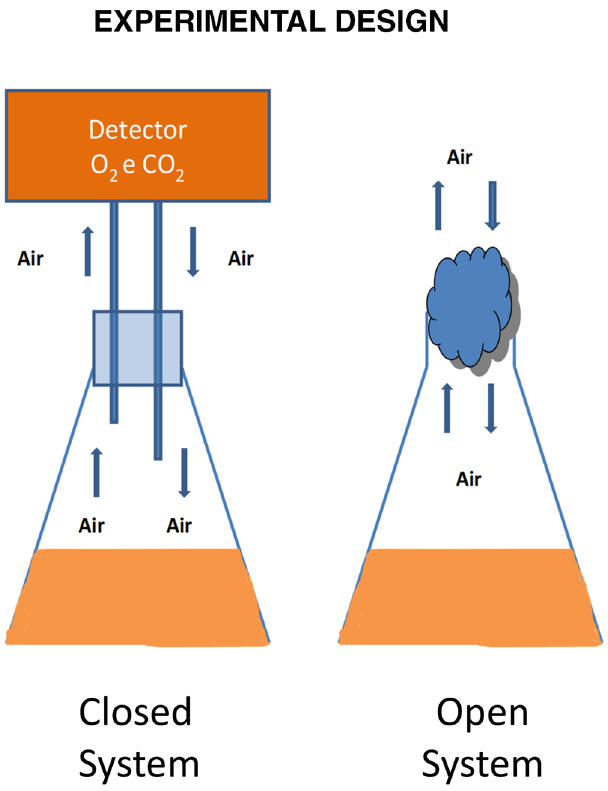
Figure 7. The closed system (CS) is equipped with a of O 2 and CO 2 detector allowing to detect during the time course of the experiment the relative quantity of the two gas. In the open system (OS) a free exchange of air between the system and the environment was